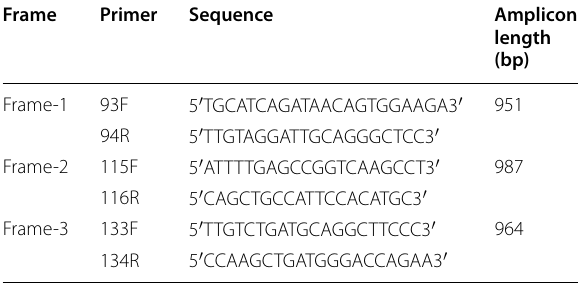
F and R represent forward and reverse primers, respectively